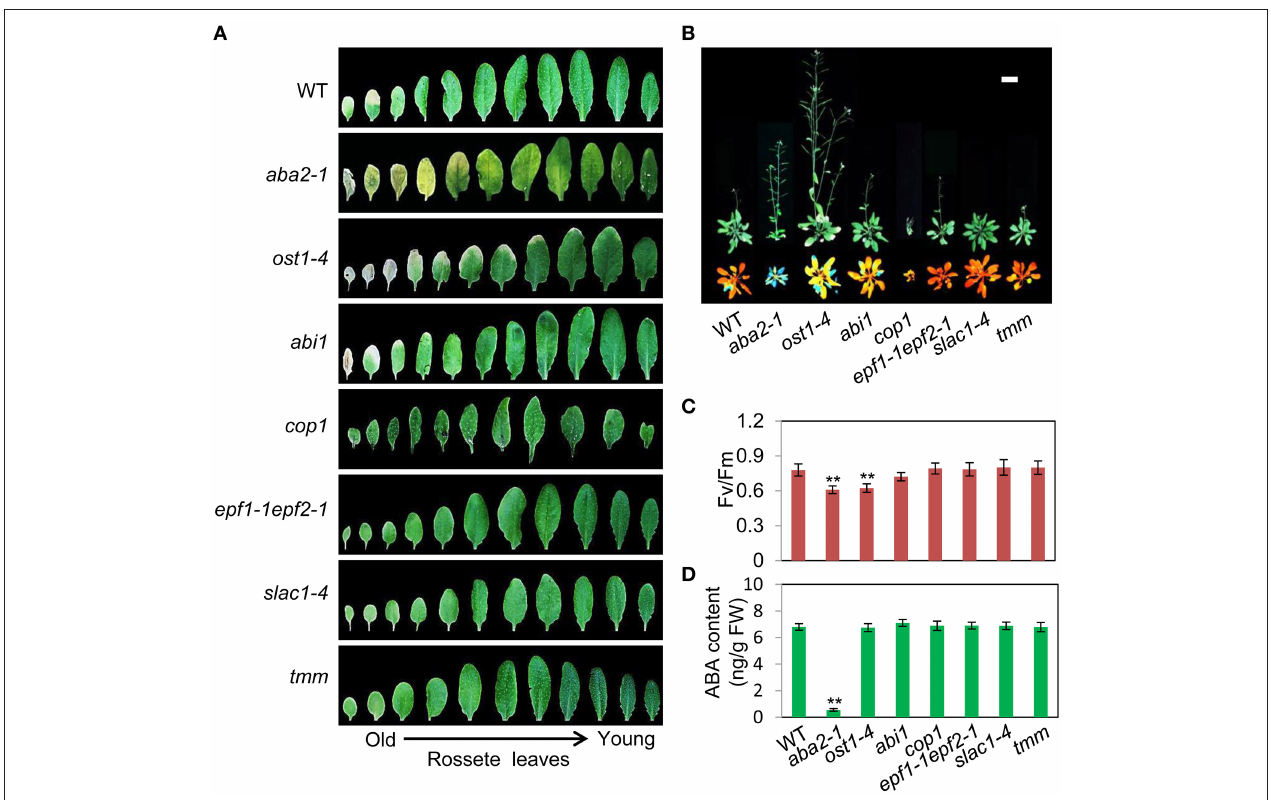
FIGURE 6 | OST1 mediates ABA regulation of leaf senescence, and stomatal behavior is not involved in this process. (A) The aging symptoms of rosette leaves at day 45 under unstressed conditions in soil. The first to eleventh rosette leaves are arranged from left to right. In order to highlight the leaf senescence phenotype, images are not to scale enlarge. (B) Representative images of wild-type and mutant plants at day 45 under unstressed conditions in soil, upper: bright; lower: chlorophyll fluorescence. The pictures show the aerial parts of plants. Bar = 5cm. (C) Fv/Fm of wild-type and mutant rosette leaves under unstressed conditions in soil at day 45. (D) ABA content of the fifth rosette leaf of wild-type and mutant plants under unstressed conditions in soil at day 25. Bars indicate standard errors, while asterisks indicate significant differences from wild-type plants under Student’s test ( ** p < 0.01 ); three experiments were performed with similar